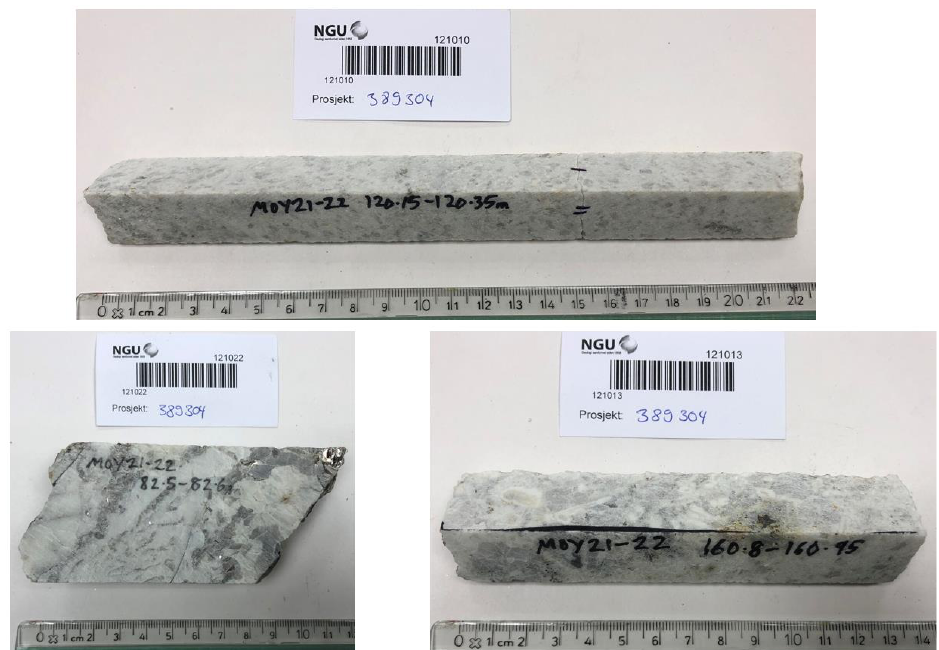
Figure 3. Photographs of three drill core samples from the LCT-type pegmatite in South Leinster (Ireland). Top: Albitized pegmatite. Bottom left: Simple pegmatite with granophyric textures. Bottom right: Spodumene pegmatite.